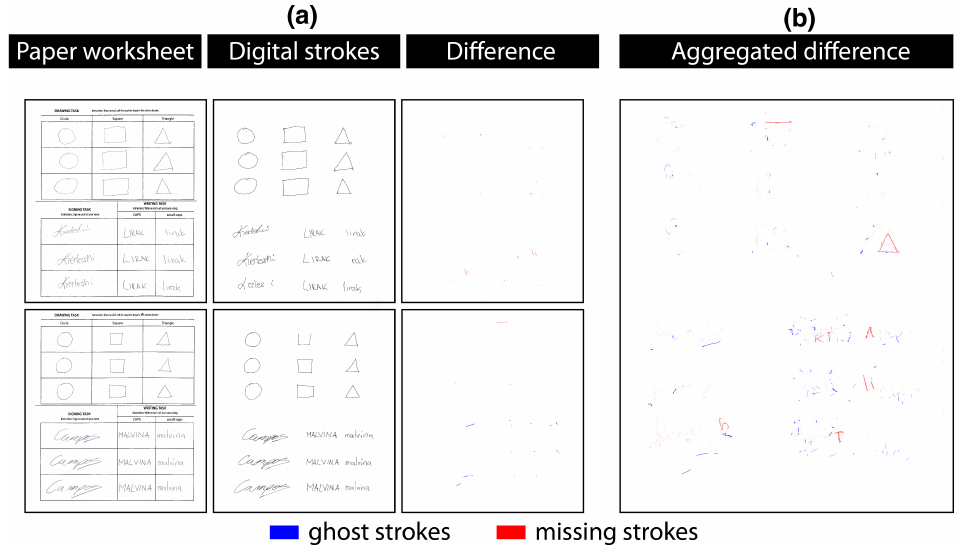
Figure 7. Visual representation of the procedure for image analysis. ( a ) Two examples of paper worksheets and their digital counterparts from two participants, together with differences between the two mediums. ( b ) Aggregated representation of missing and added strokes of all participants.